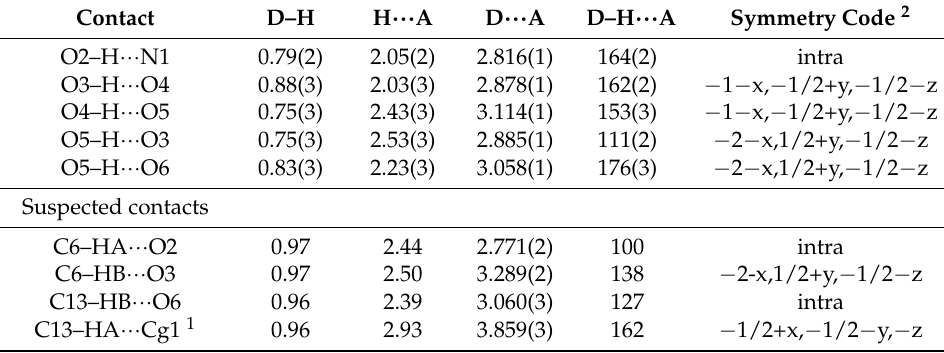
Table 2. Hydrogen bonding geometry (Å, ◦ ) in the crystal structure of N -(1-deoxy- α - D -tagatopyranos- 1-yl)- N -methylaniline.